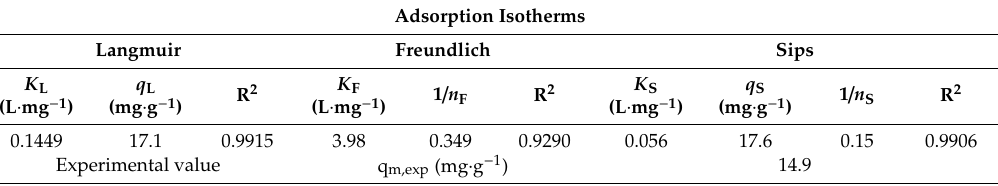
Table 8. Parameters of isotherm model for adsorption of Pb 2 + onto magnetic nanocomposite.